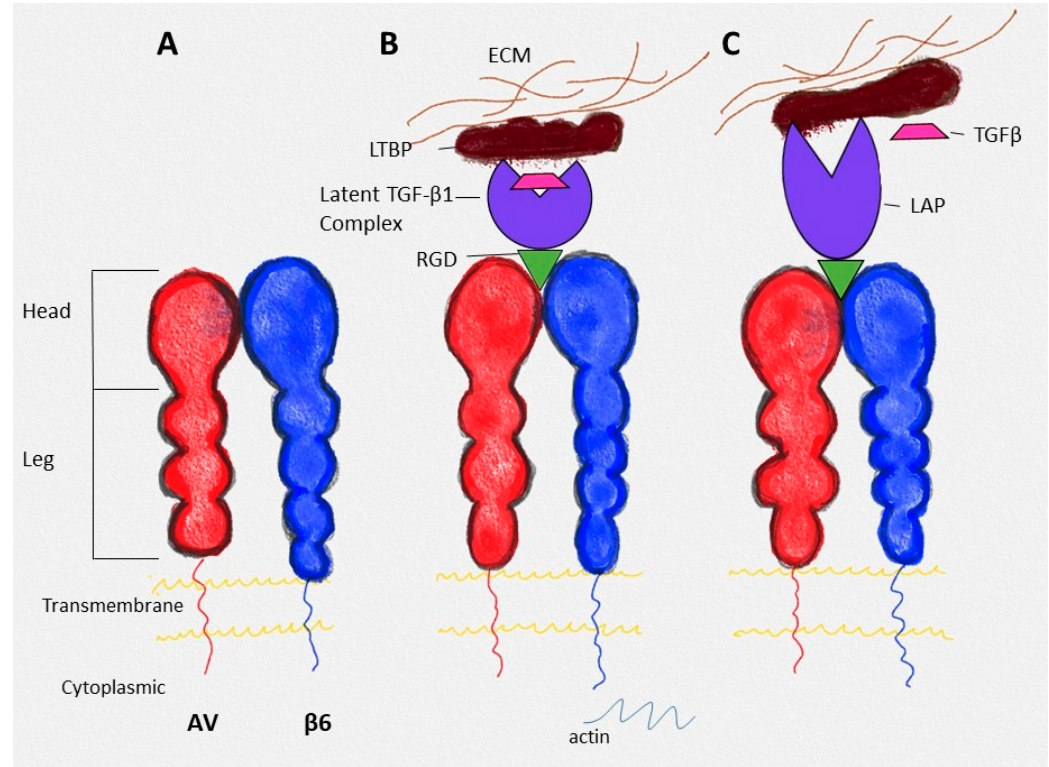
Figure 2. ( A ) Structure of integrin α v β 6; ( B ) binding of latent TGF- β complex with α v β 6 (the complex is bound to the latent TGF- β 1 binding protein—LTBP); ( C ) activation of TGF- β (modified) [13]. Reprinted/adapted with permission from Ref. [13]. 2022, Elsevier.